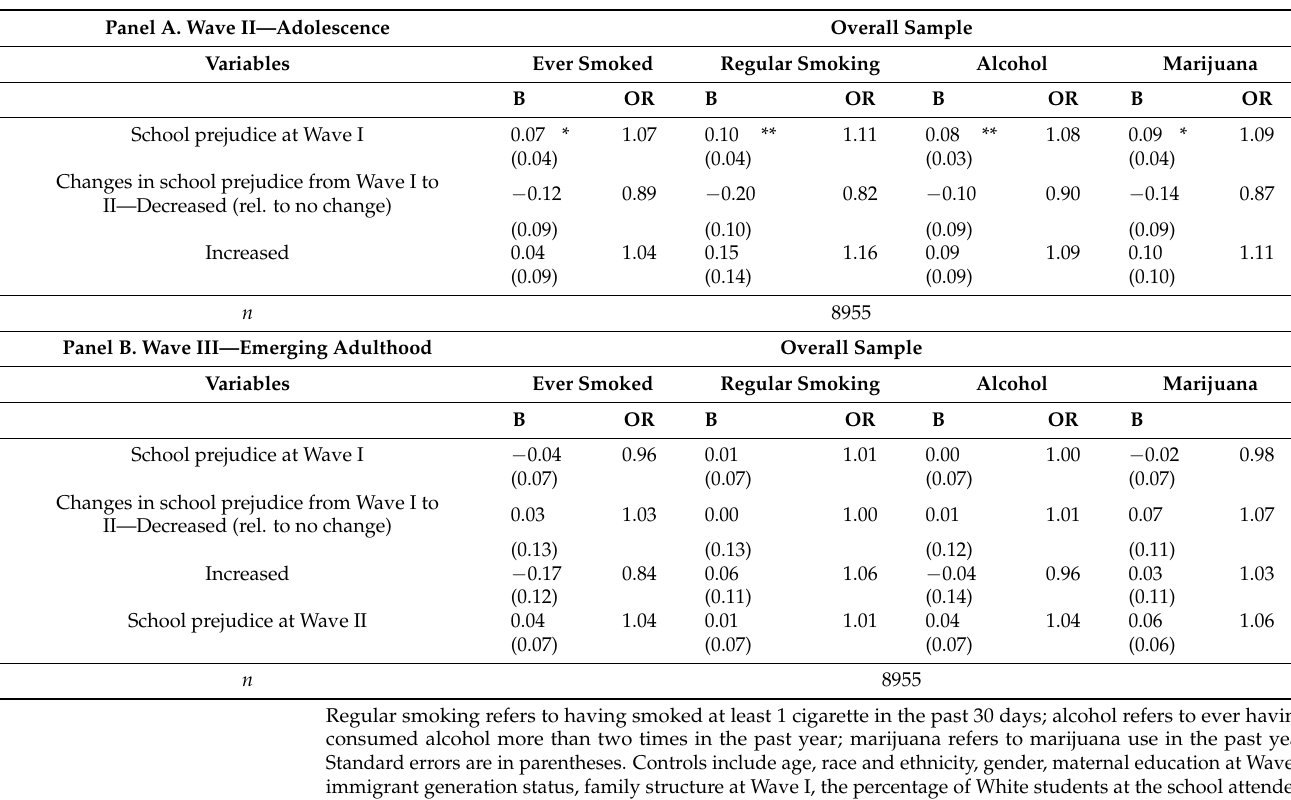
Table 3. Likelihood of substance use for the full sample in Waves II and